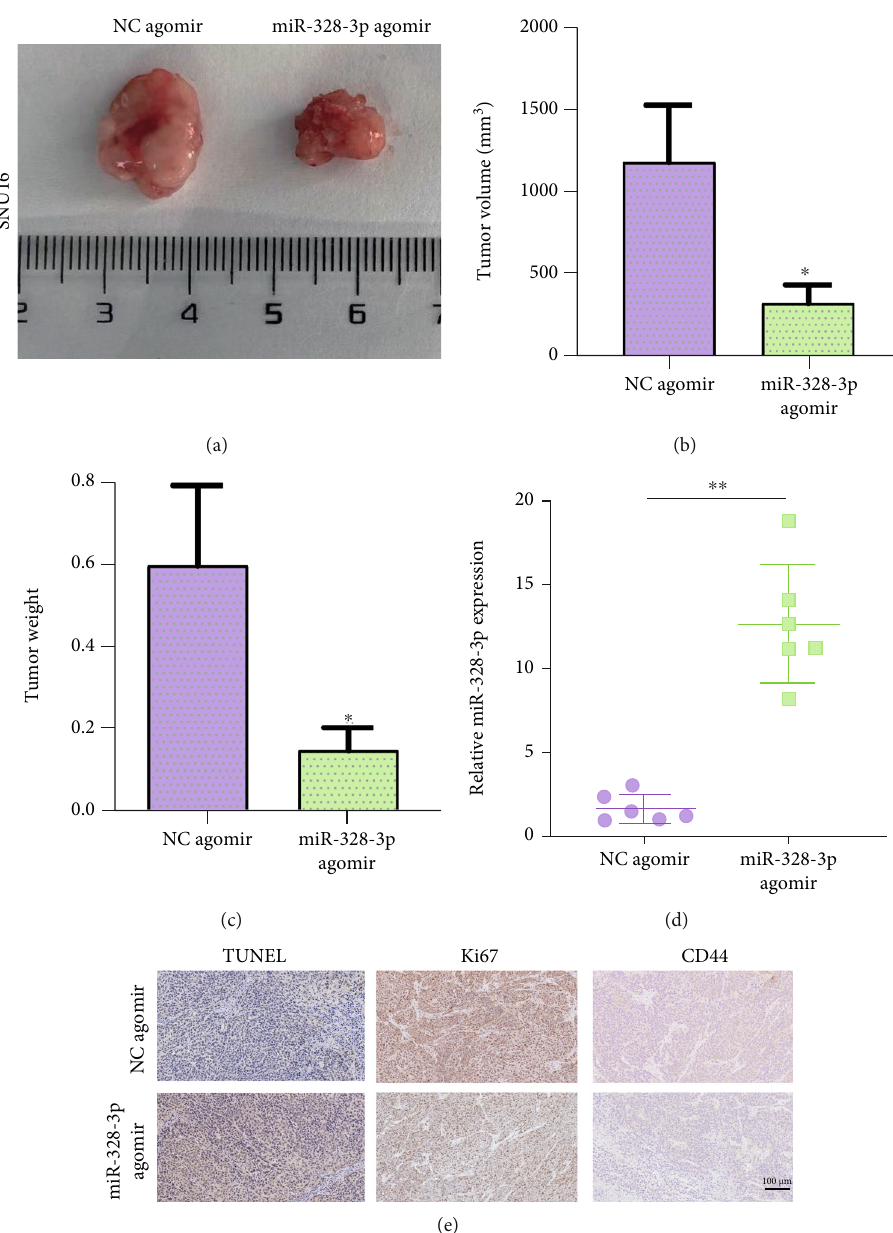
Figure 7: miR-328-3p inhibited tumor growth of STAD in vivo . SNU16 cells transfected with NC agomir or miR-328-3p agomir were subcutaneously injected into nude mice for observation of tumor growth. (a) The images of tumor tissues from the NC agomir and miR- 328-3p agomir groups. (b) Tumor volume. (c) Tumor weight. (d) qRT-PCR assay was utilized to detect the expression level of miR-328- 3p in xenografts. (e) IHC was employed to measure the expression levels of CD44 and Ki67 in xenograft tumors, and TUNEL staining was used to measure apoptotic cells in tumors. All experiments were performed in triplicate. ∗ P < 0 : 05 , ∗∗ P < 0 : 01